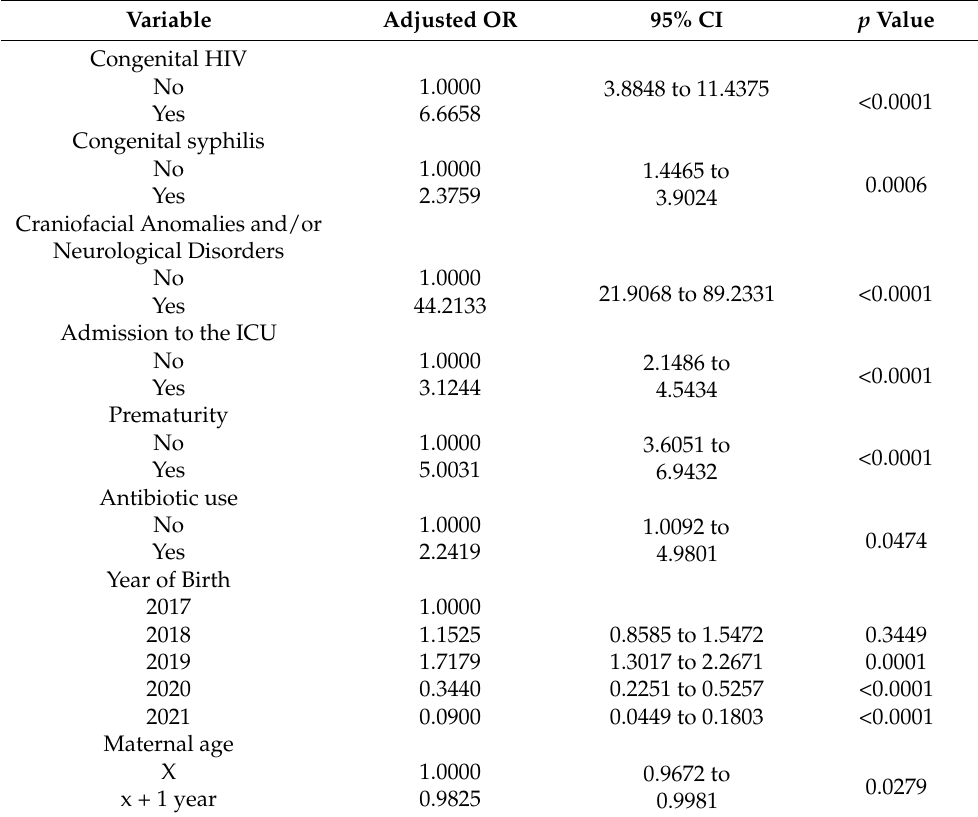
Table 3. Odds ratio adjusted using the Cochran–Mantel–Haenszel method for the association between UNHS failure, newborns with RIHL, or mother-related variables. Florian ó polis, SC, 2017 to 2021 (n = 34,801). Variable Adjusted OR 95%